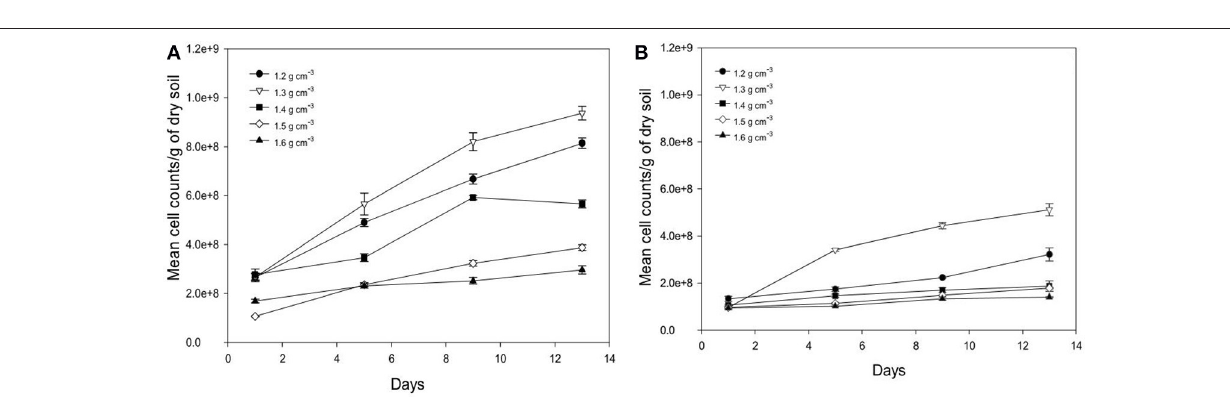
and 3.0 times for Bacillus with cell densities of 9.17E + 08